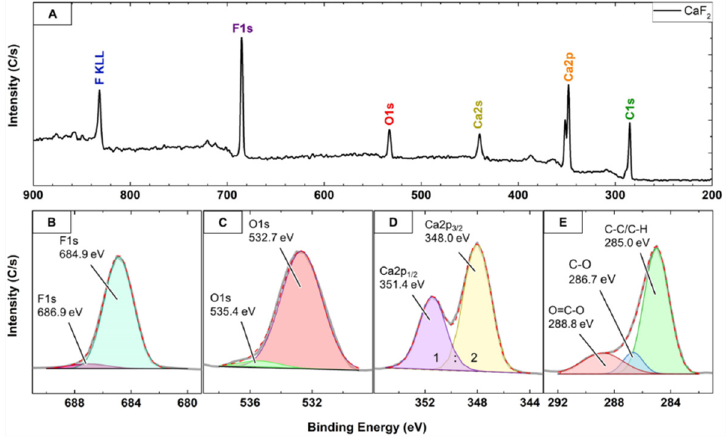
Figure 4. X-ray photoelectron spectra of part -CaF 2 . ( A ) Survey spectrum confirming the main characteristic atomic components. ( B ) F1s deconvolution. ( C ) O1s deconvolution. ( D ) Typical Ca2p spin-orbit splitting for Ca(II). ( E ) Chemical environment of the C1s peak.